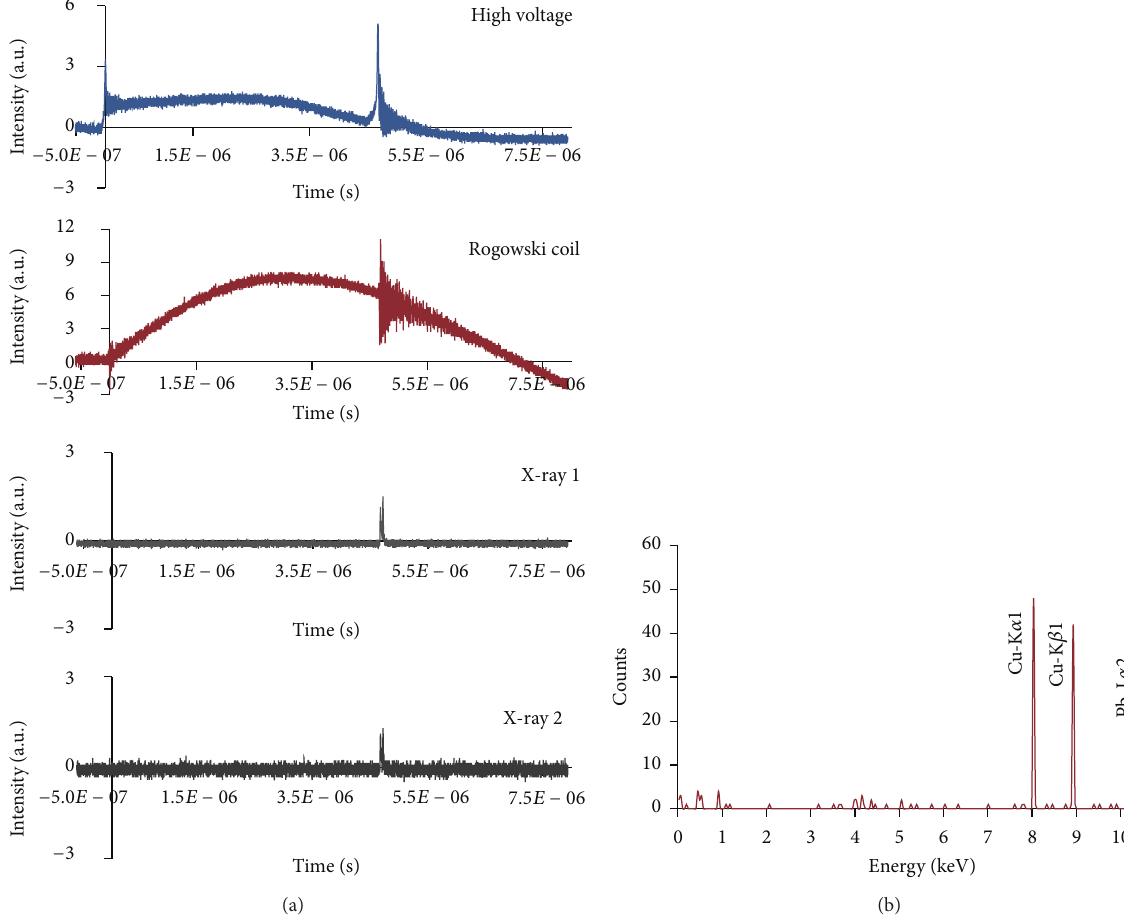
Figure 8: (a) Temporal evolution of X-ray pulses with Al foil thickness for pressure 1.7mbar, X-ray 1 (23 𝜇 m aluminized Mylar plus 30 𝜇 m Al foil) and X-ray 2 (23 𝜇 m aluminized Mylar plus 20 𝜇 m Al foil) with typical high voltage and Rogowski coil signal. (b) X-ray spectrum: X-ray produced by energetic electron beam-target effect at an angle of 45 ∘ when the spectrometer is at side-on position.